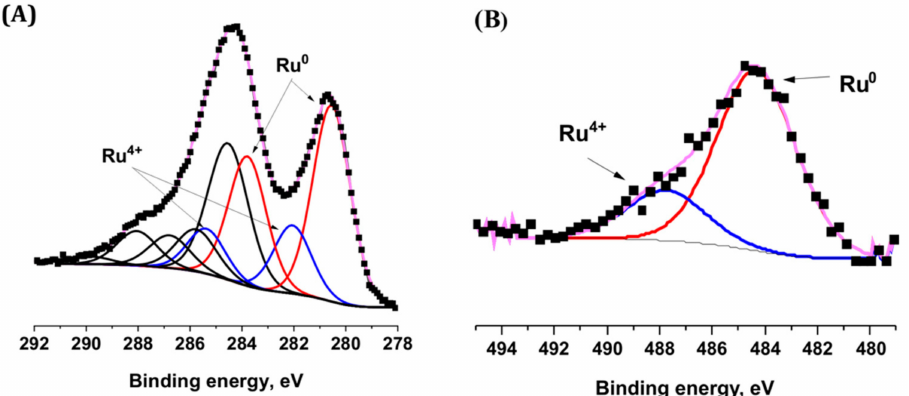
Figure 7. ( A ) Ru 3d + C 1s; ( B ) Ru 3p XPS profile of the Ru(5 wt.%)/TiO 2 -P25 catalyst. No presence of any residual chlorine was observed by XPS at the surface of TiO 2 when the chloride precursor was used (Cl 2p XPS spectra not shown).